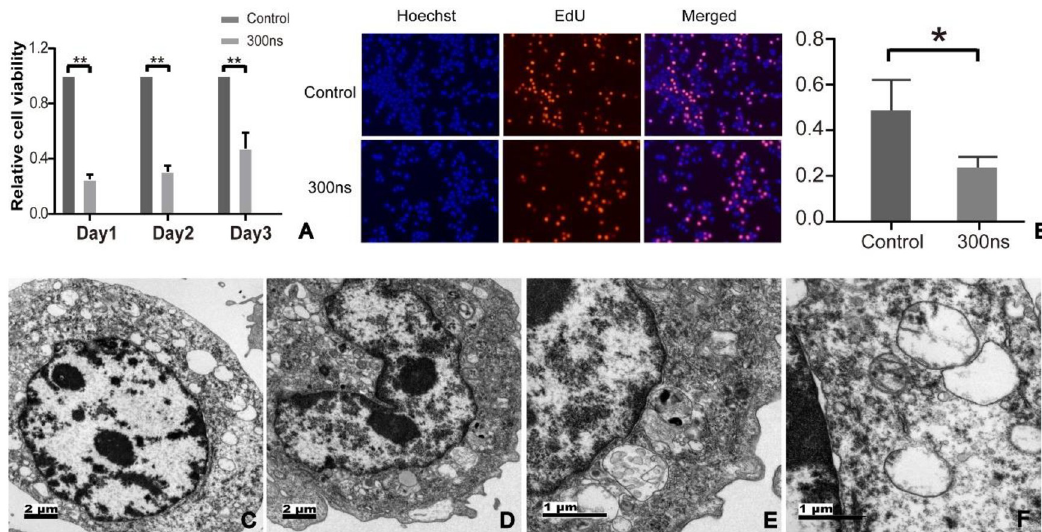
Fig 2. Hep3B cell behavior experiments. A : Hep3B cells were treated in cuvettes as shown in Fig 1B with 2.5 × 10 6 cells with pulses with durations of 0 and 300 ns and pulse numbers of 800, respectively. At days 1, 2, and 3 after treatment cell viability was determined by the CCK-8 assay. B : Hep3B cells were treated with pulsed electric field under the above parameters and inoculated into the confocal plate at a density of 10 × 10 5 cells per well, and then a cell proliferation experiment was conducted. C-F : Hep3B cells treated with the pulsed electric field for 2 h were observed by transmission electron microscopy ( C and D , original magnification × 2500; E and F , original magnification × 10000). Data are expressed as the mean ± SD. � P < 0.05; �� P < 0.01; ��� P < 0.001. nsPEFs: nanosecond pulsed electric